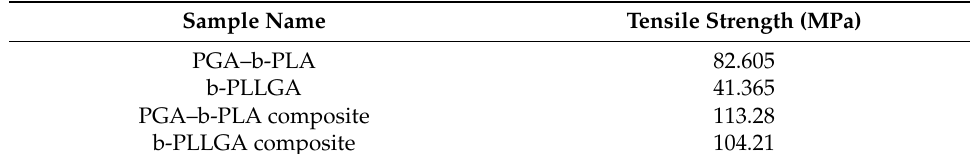
Table 3. Tensile test results of UTM according to the ISO 527-2 guideline.